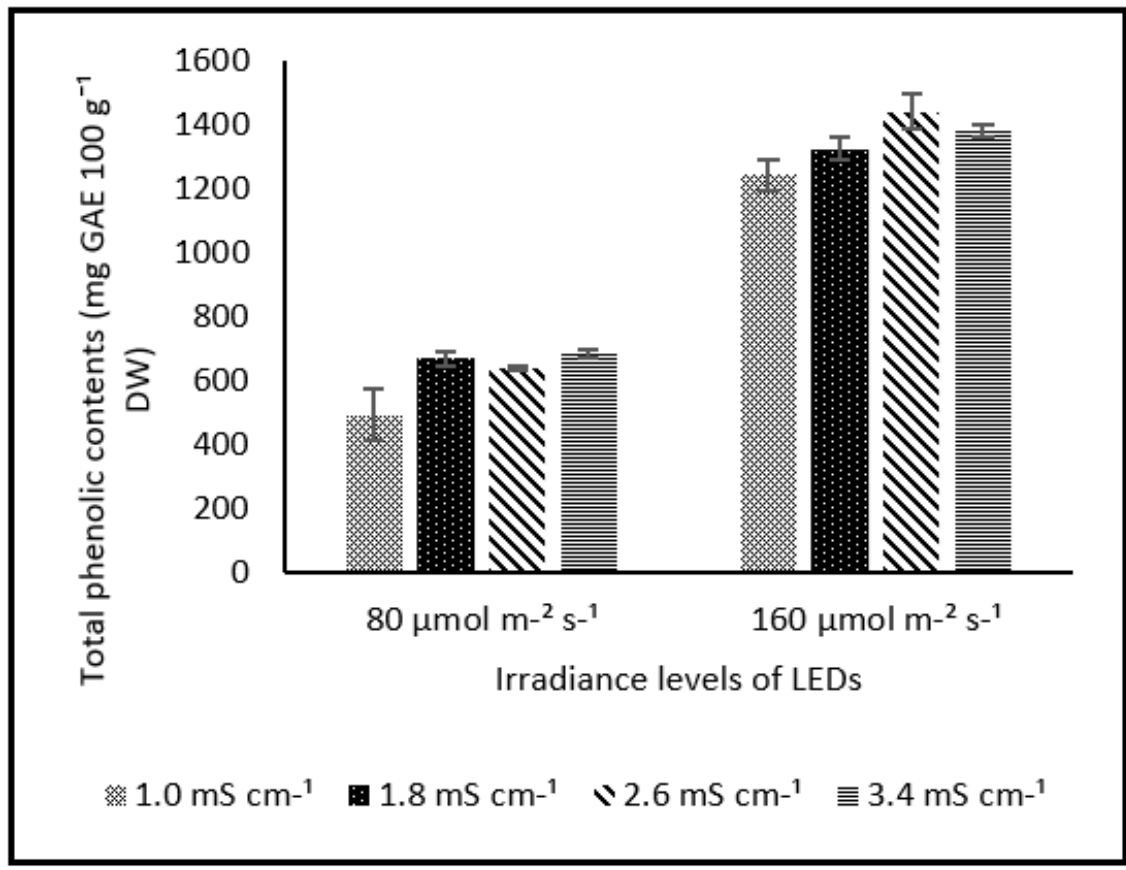
Figure 6. Interaction effect of LED irradiance levels and nutrient solution EC on total phenolic content of lemon